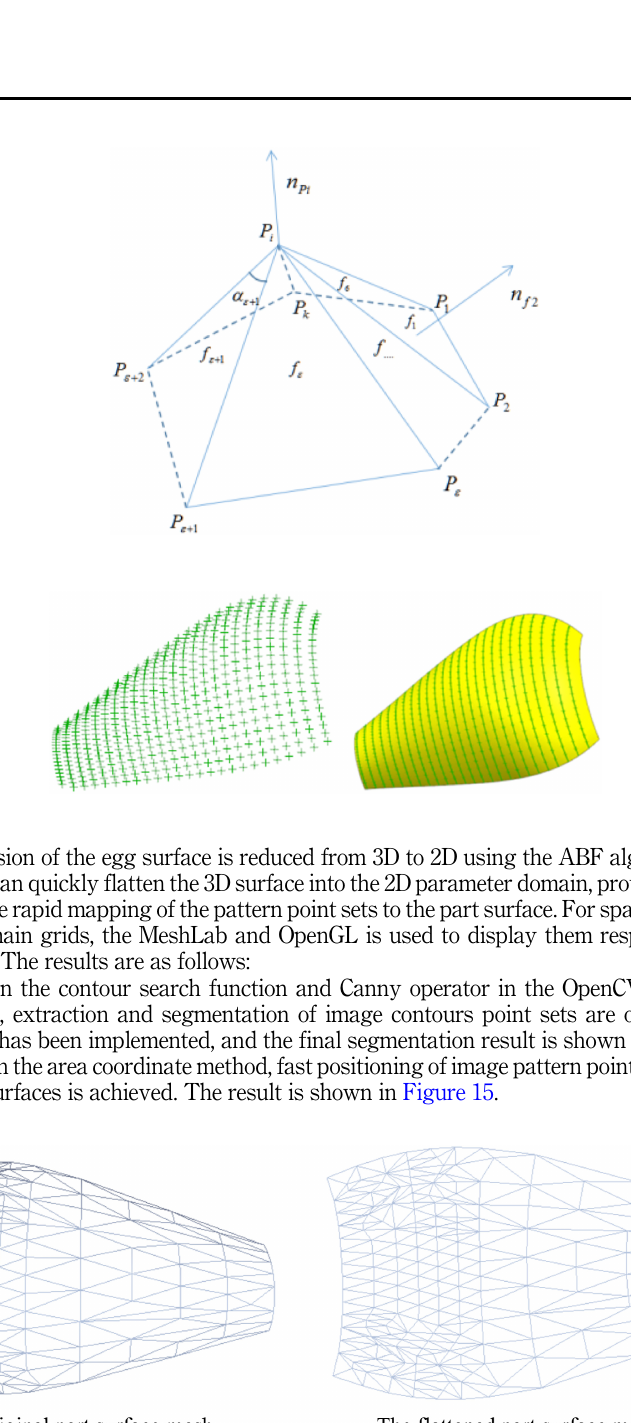
Figure 13. (a) The original part surface mesh; (b) The flattened part surface